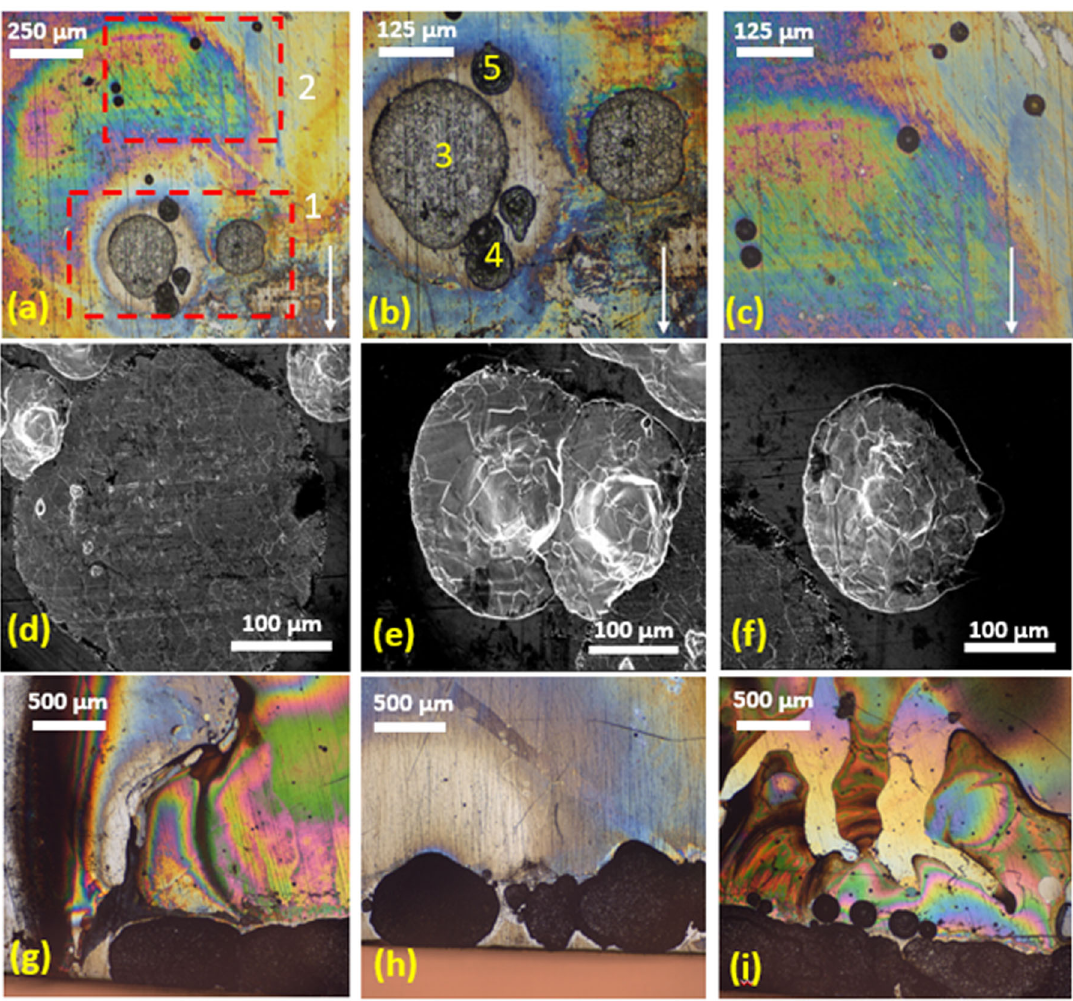
Fig. 1 Morphology of crevice corrosion observed on SS( + ISG) in 0.6 M NaCl after 12 months of exposure. a An optical microscopy image of SS( + ISG). The optical micrograph of regions 1 and 2 bounded by the red boxes are shown in ( b ) and ( c ) respectively. The white arrow is in the direction of the crevice mouth which is not visible in these images. d – f SEM (secondary electron) images of corrosion morphology observed. d corresponds to the pit numbered 3 in ( b ), ( e ) corresponds to the pit numbered 4 in ( b ) and ( f ) corresponds to the pit numbered 5 in ( b ). g – i Optical microscopy images of SS( + PTFE) showing extensive crevice